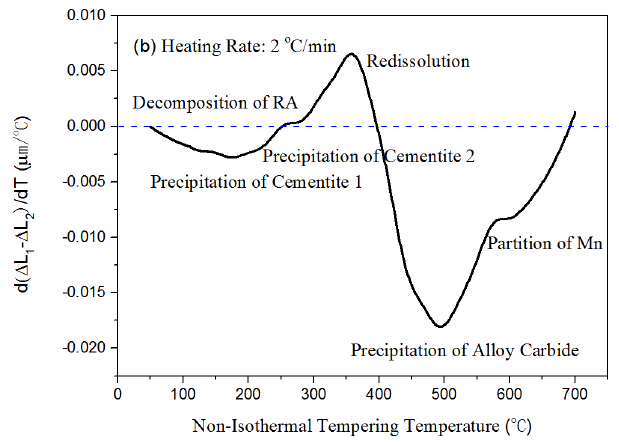
Figure 3. Changes in length during non-isothermal tempering of 700L. ( a ) The changes in specimen length during the two tempering processes and the corresponding di ff erences; ( b ) The first derivative of the di ff erence between the changes in the length for the first and second tempering steps.